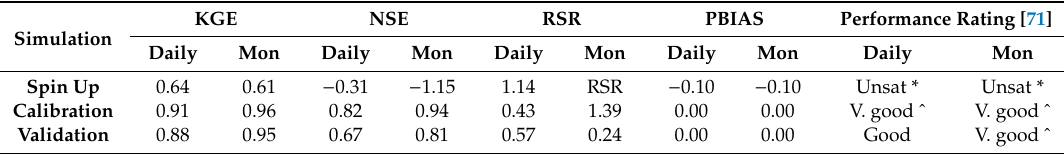
Table 4. Model performance statistics to evaluate the Storm Water Management Model (SWMM) daily and monthly lake water level simulations.